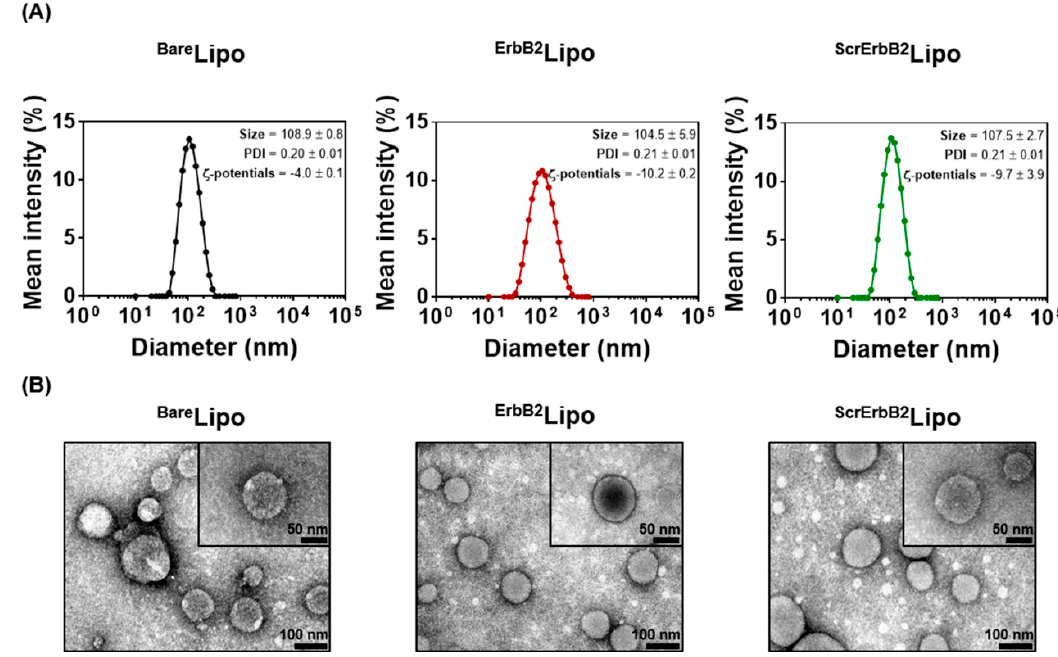
Figure 3. Physicochemical characteristics of the liposomes. ( A ) The particle size, polydispersity index (PDI), and zeta-potential values were measured using dynamic light scattering. ( B ) Transmission electron microscope images of Bare Lipo, ErbB2 Lipo, and ScrErbB2 Lipo.